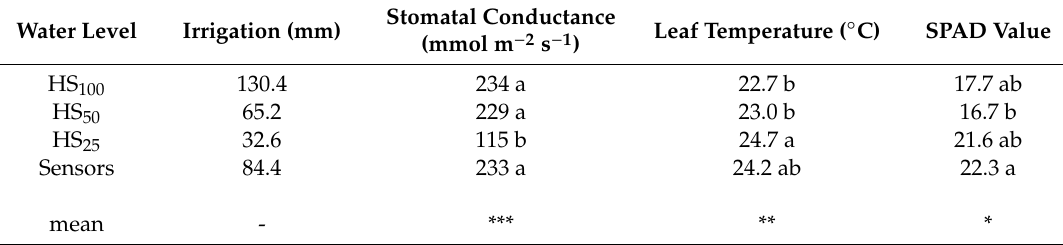
Table 2. Experiment 1: E ff ect of irrigation strategy on the physiological parameters of lettuce. Di ff erent letters indicate significant di ff erences at Tukey HSD test ( p ≤ 0.05). Data are the means of three